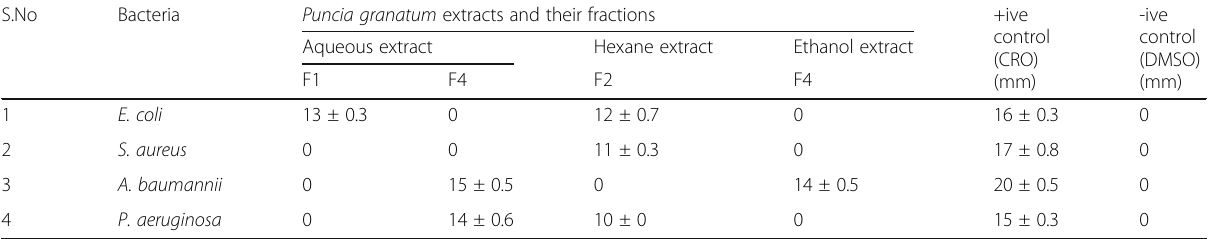
Table 1 Zone of inhibition showed by HPLC fractions of P. granatum peel extract S.No Bacteria Puncia granatum extracts and their